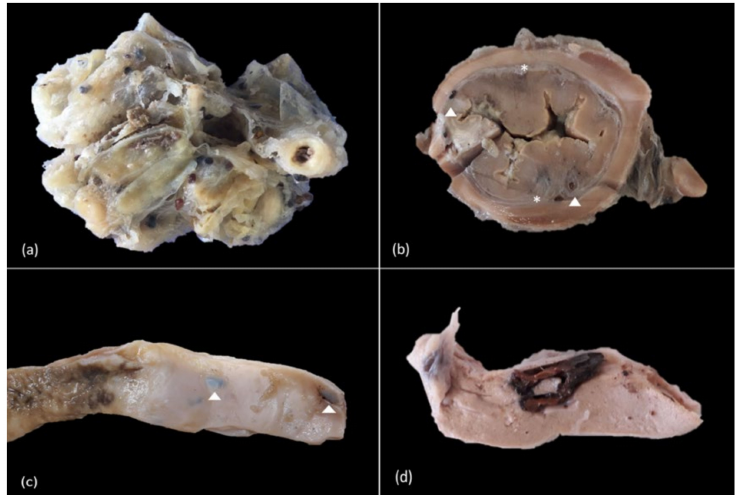
Figure 4. Location of the parasitic cysts and nodules. ( a ) Mesenteric fat and peritoneum, numerous cysts embedded in fibrous connective tissue. ( b ) Transversal section of the stomach, numerous cysts (arrowhead) in the submucosa with profuse deposition of mature fibrous connective tissue (*). ( c ) Intestine, multifocal, transmural larvae-filled cysts (arrowhead). ( d ) Liver, large dark brown nodule invading and displacing the hepatic